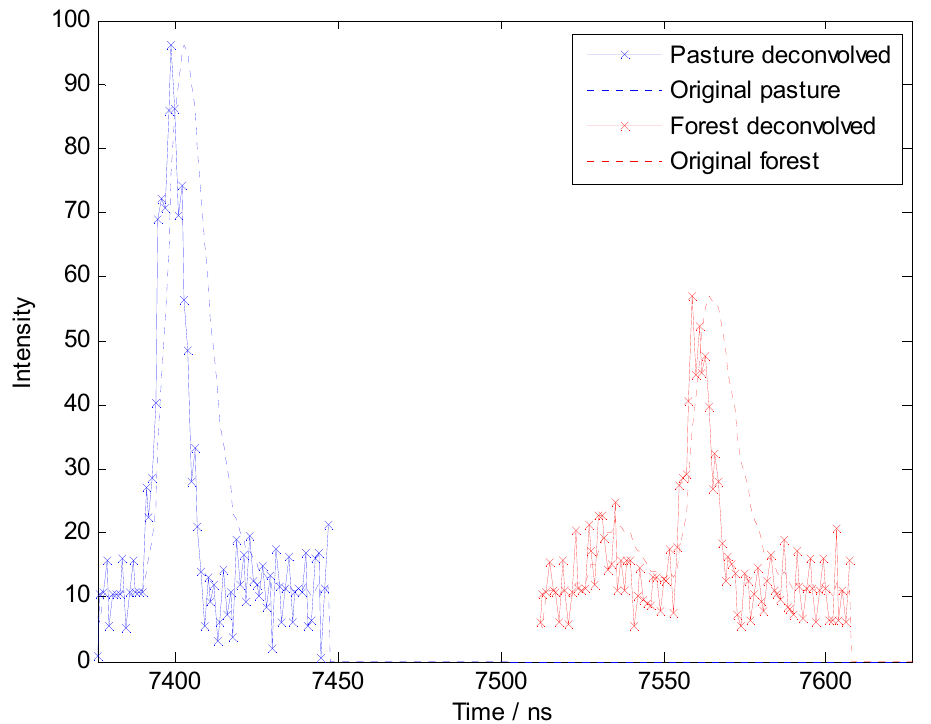
Figure 3. Convolved and deconvolved forms of the waveforms in Figure 2 from pasture and from